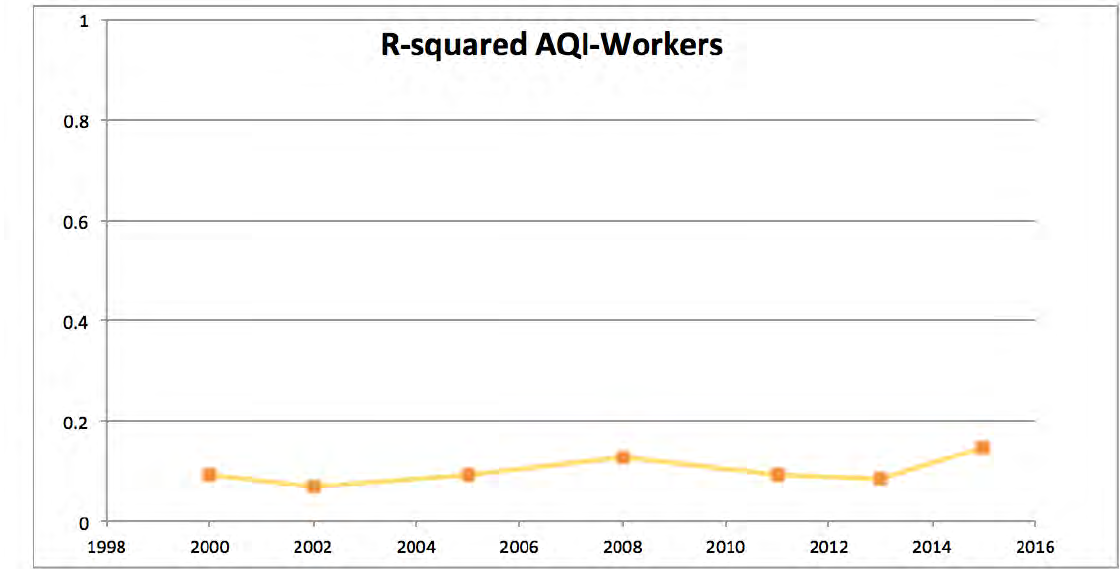
Figure 4. R-squared between AQI-Workers for the US metro areas in the period